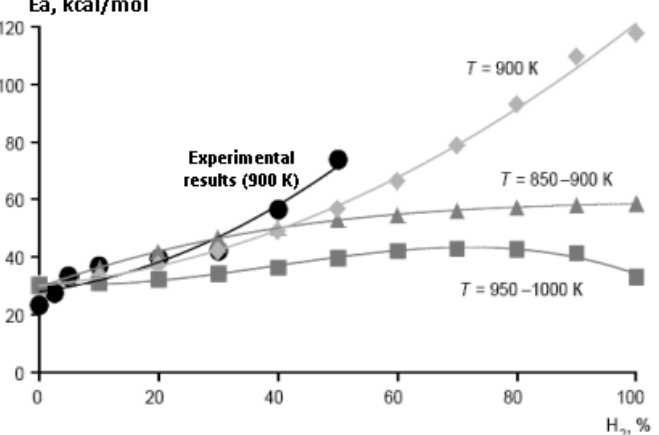
Figure 13. Dependence of the effective activation energy (Ea, kcal/mol) of the ignition delay time in air of stoichiometric methane–hydrogen mixtures on the concentration of hydrogen in them at P 0 = 1 bar, ( ● ) experimental results (T 0 = 900 K), calculation at T 0 (K) 850–900 ( ▲ ), 900 ( ♦ ) and 950–1000 ( ■ ) (Adapted with permission from ref. [29], Copyright 2020, TORUS PRESS).